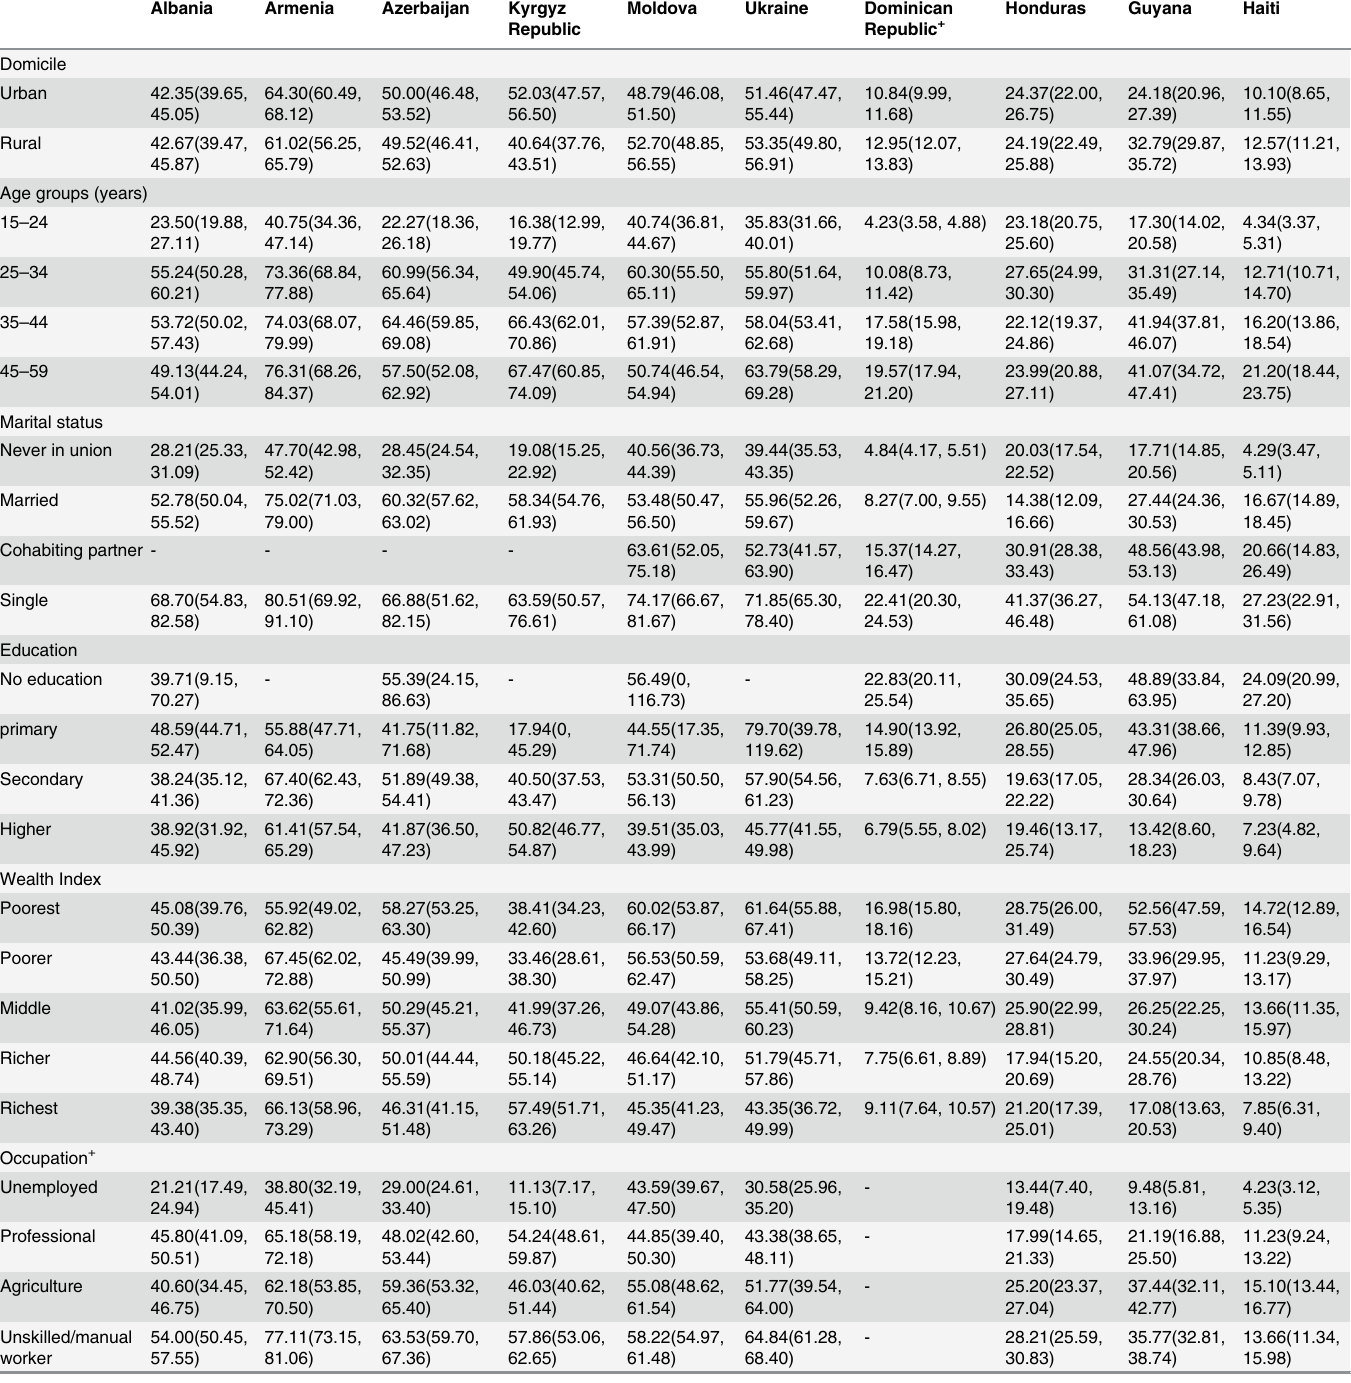
Table 3. Weighted prevalence estimates (%) and 95% CIs of smoking by social factors among men in 10 countries (Central and West Asia, Latin America and